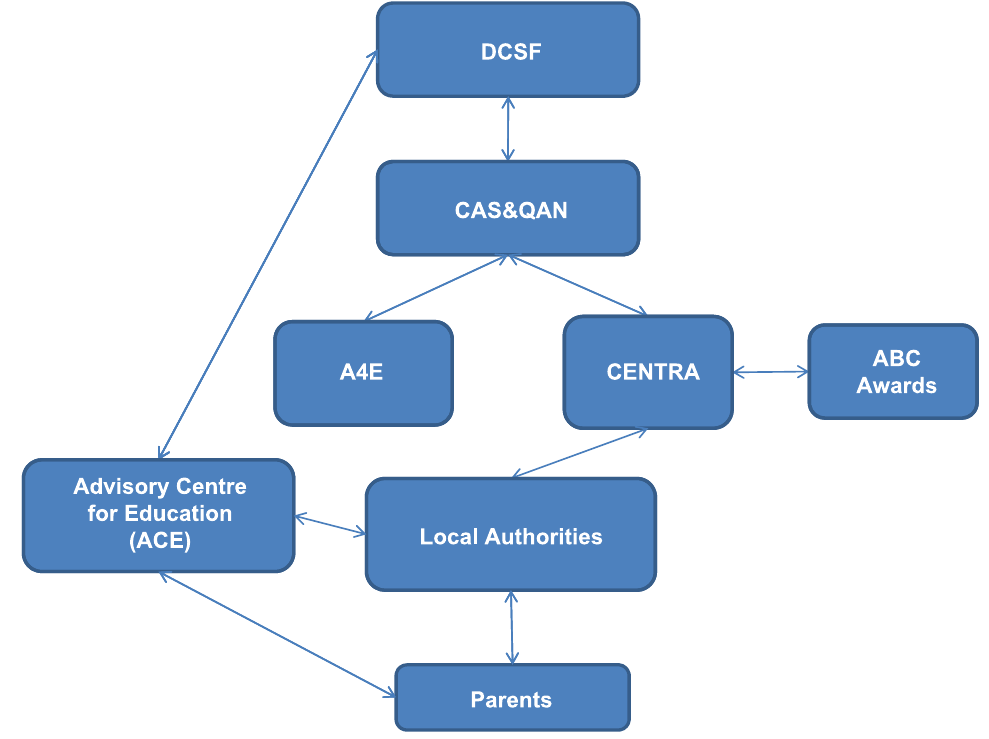
Figure 1. Mapping choice advice networks of policy and